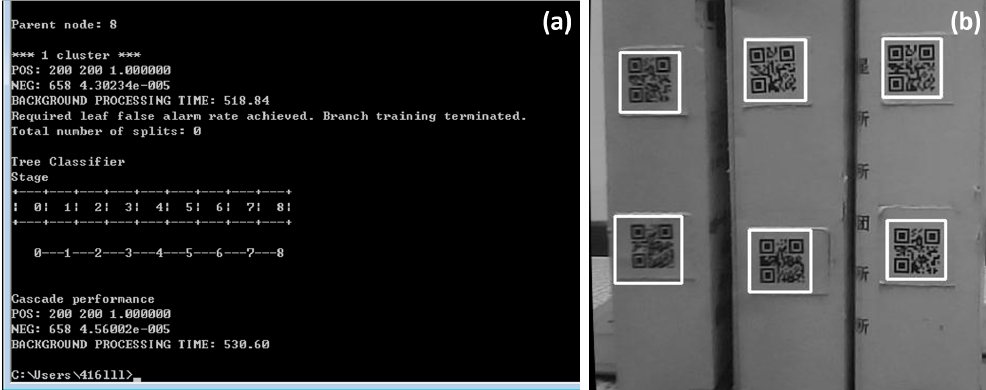
Figure 13. ( a ) QR code image classification results, based on the Haar feature; ( b ) QR code identification